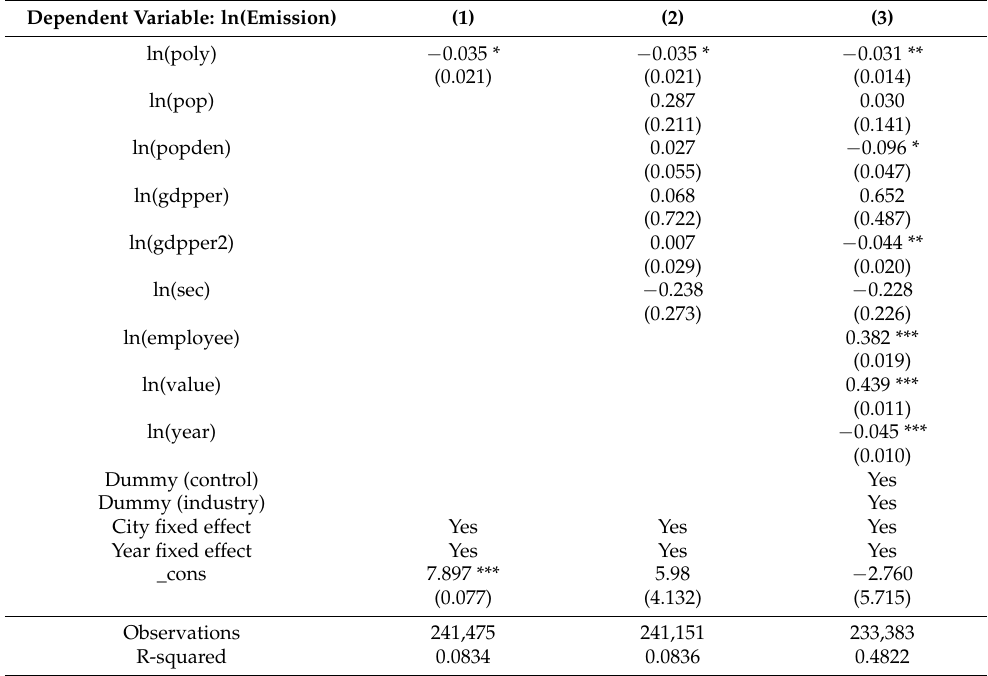
Table 2. Baseline